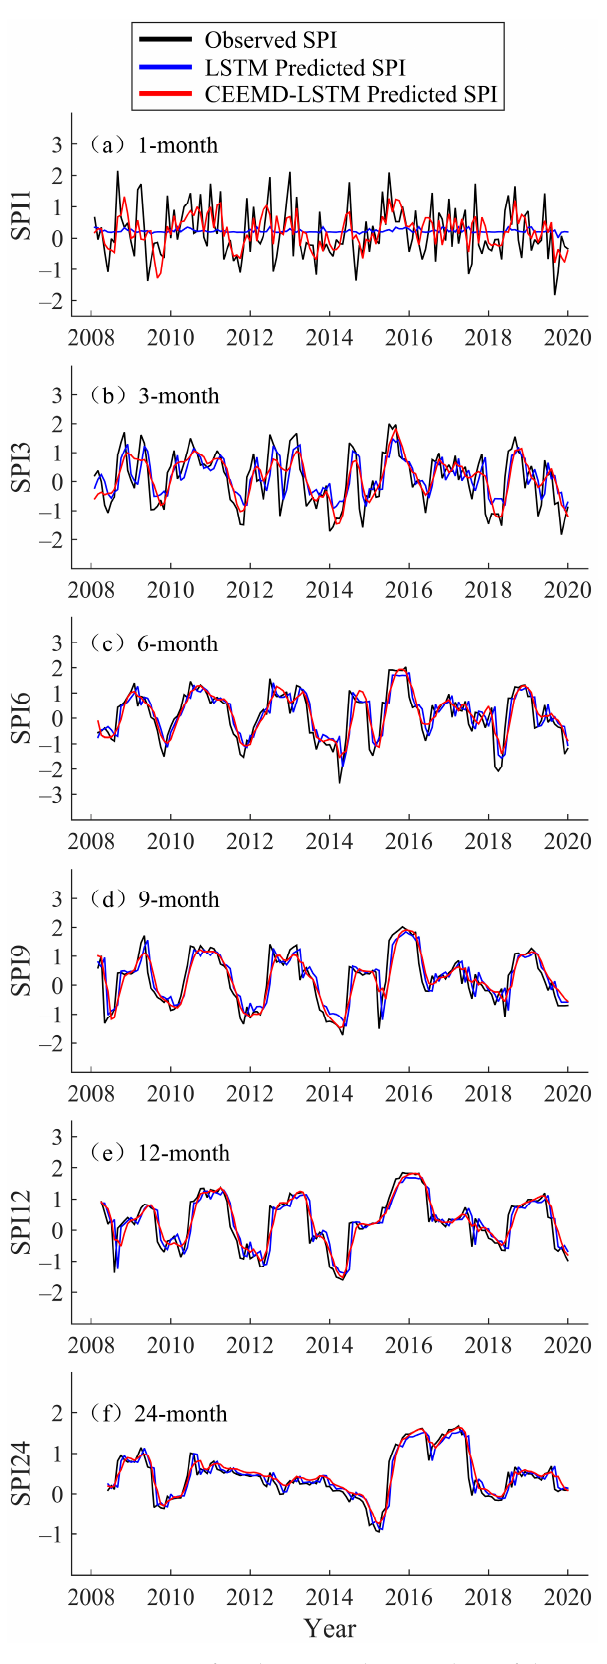
Figure 8. Forecast of multi-timescale SPI values of the LSTM and CEEMD-LSTM model at Hami Station (2008–2019).